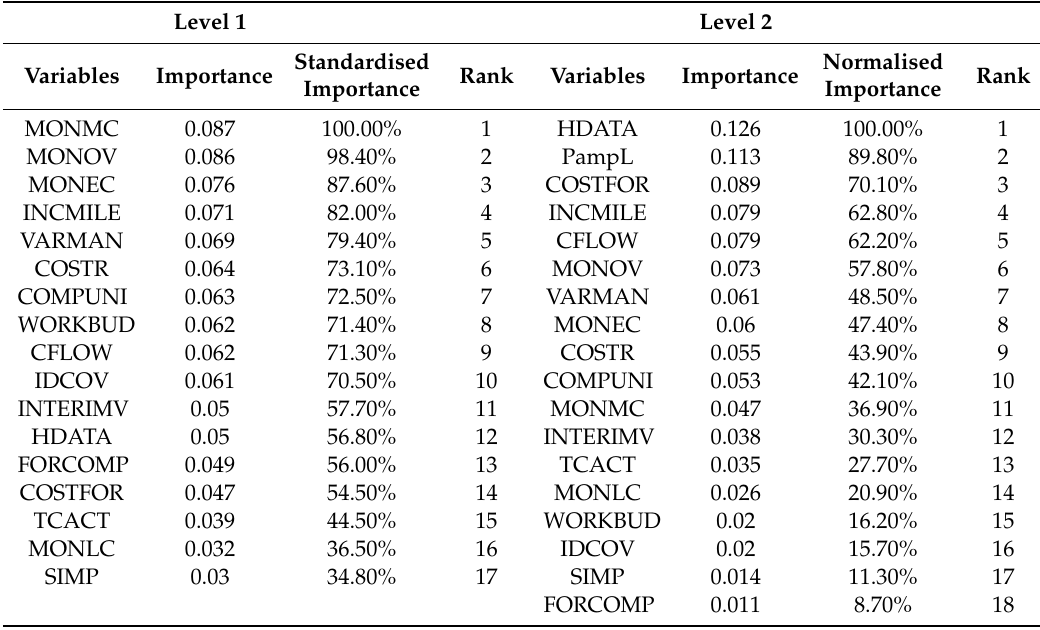
Table 6. Independent variable importance for 2 training sessions (noted: Level 1 has PampL as a partition variable in the training set). Level 1 Level 2